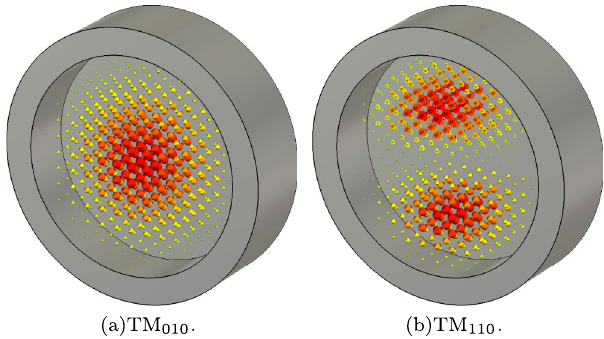
FIG. 2. Distribution of the electric field in a pillbox cavity for two basic modes, as calculated by CST MICROWAVE STUDIO (cid:1)